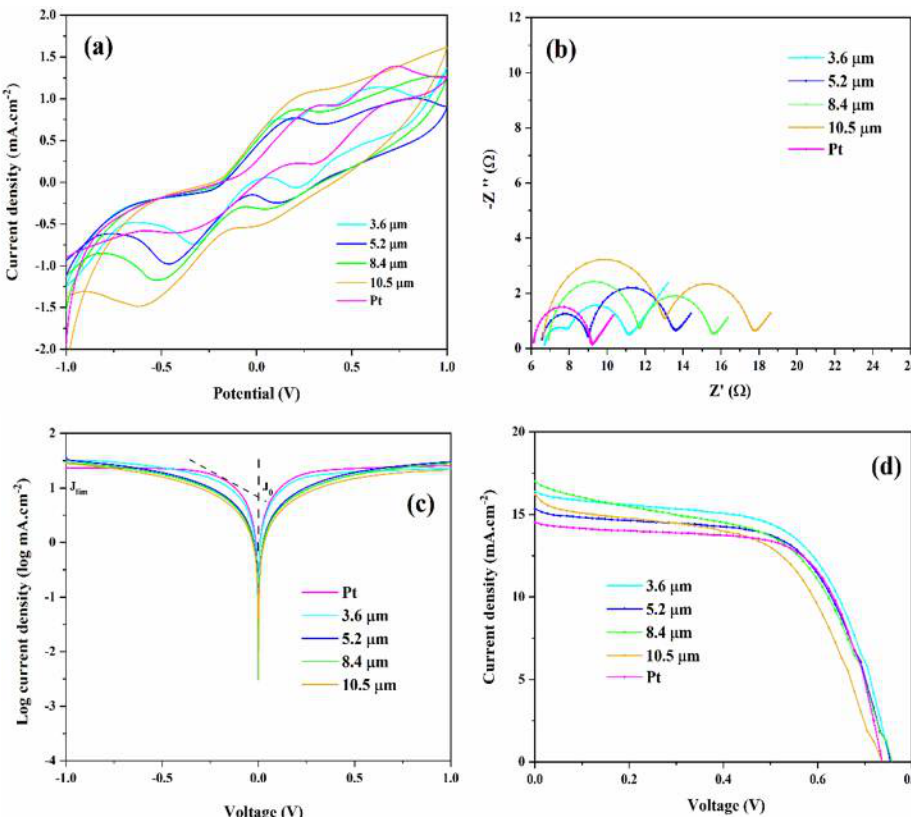
Figure 6. CV plots at 50 mV · s − 1 scan rate ( a ); EIS Nyquist plots ( b ); Tafel polarization plots ( c ); DSSC J–V plots ( d ) of 2-L@F@CB CEs with different film thicknesses.